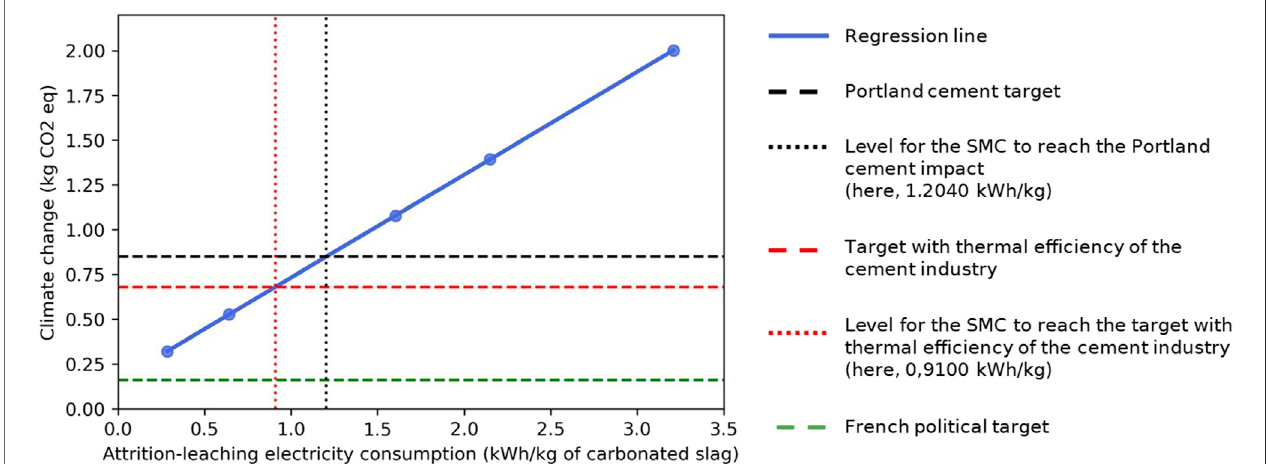
FIGURE 7 | Assessment of the attrition-leaching electricity consumption depending on the climate change impact objective — the regression line is blue, the black dashedlineistheimpactof1 kgofPortlandcementandtheblackdottedlineistheconsumptiontoreachthePortlandcement,thesameisfortheredlines,representing the case of thermal ef fi ciency of the cement industry with a 20% reduction target, and the green dashed line is the 81% reduction target that should be reached in 2050 according to the French policy target.